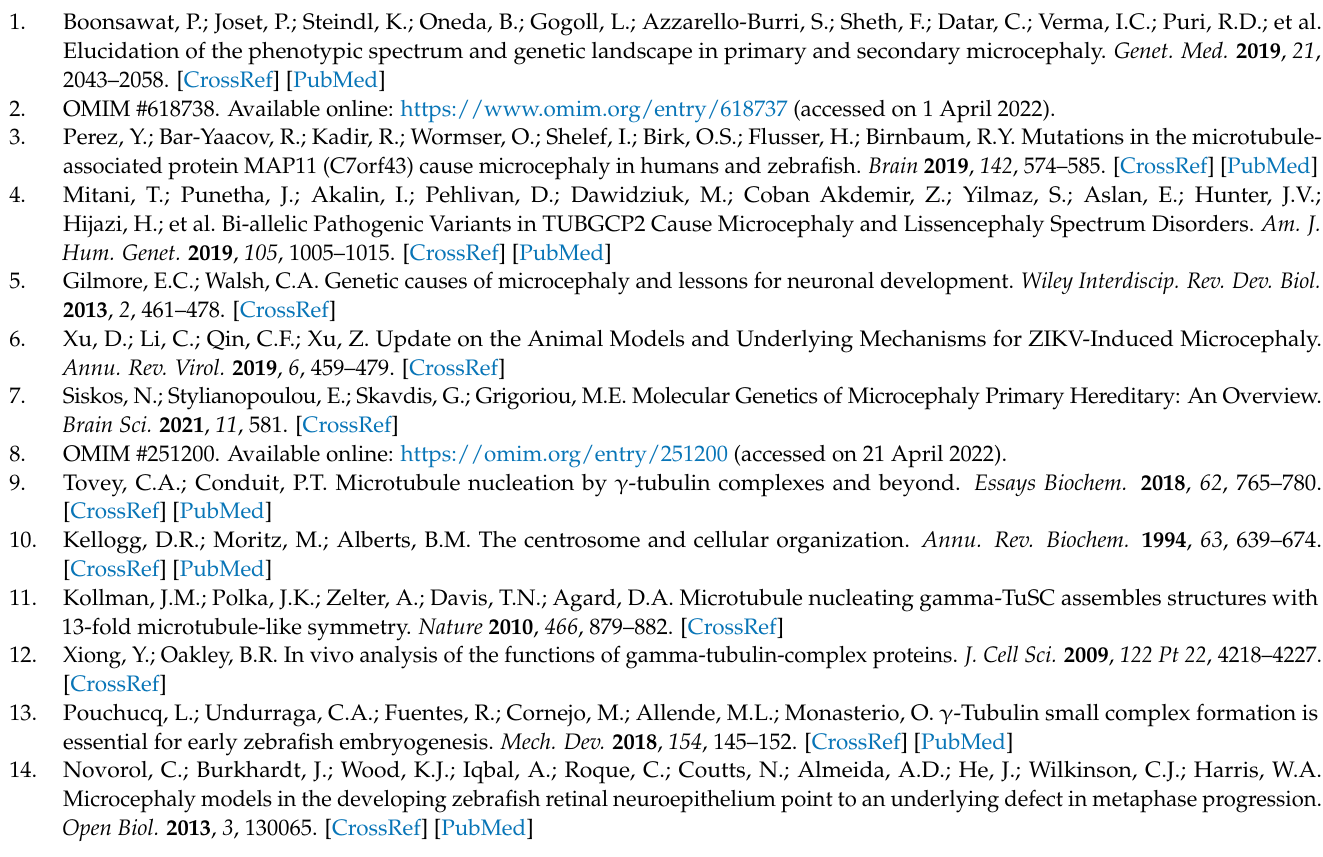
Figure S1: Organisation of the Grip84 gene in Drosophila melanogaster